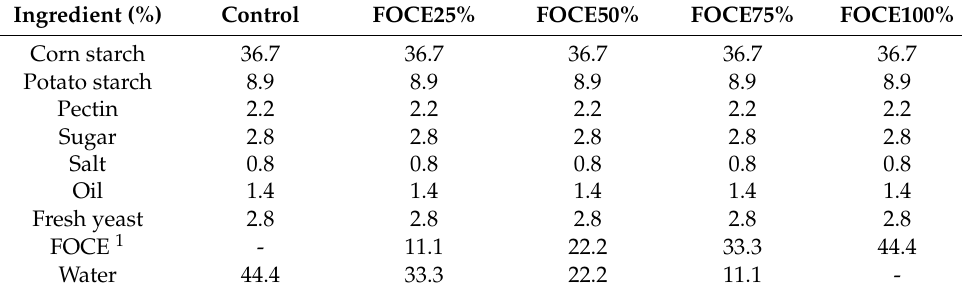
Table 1. Ingredients of experimental gluten-free bread with